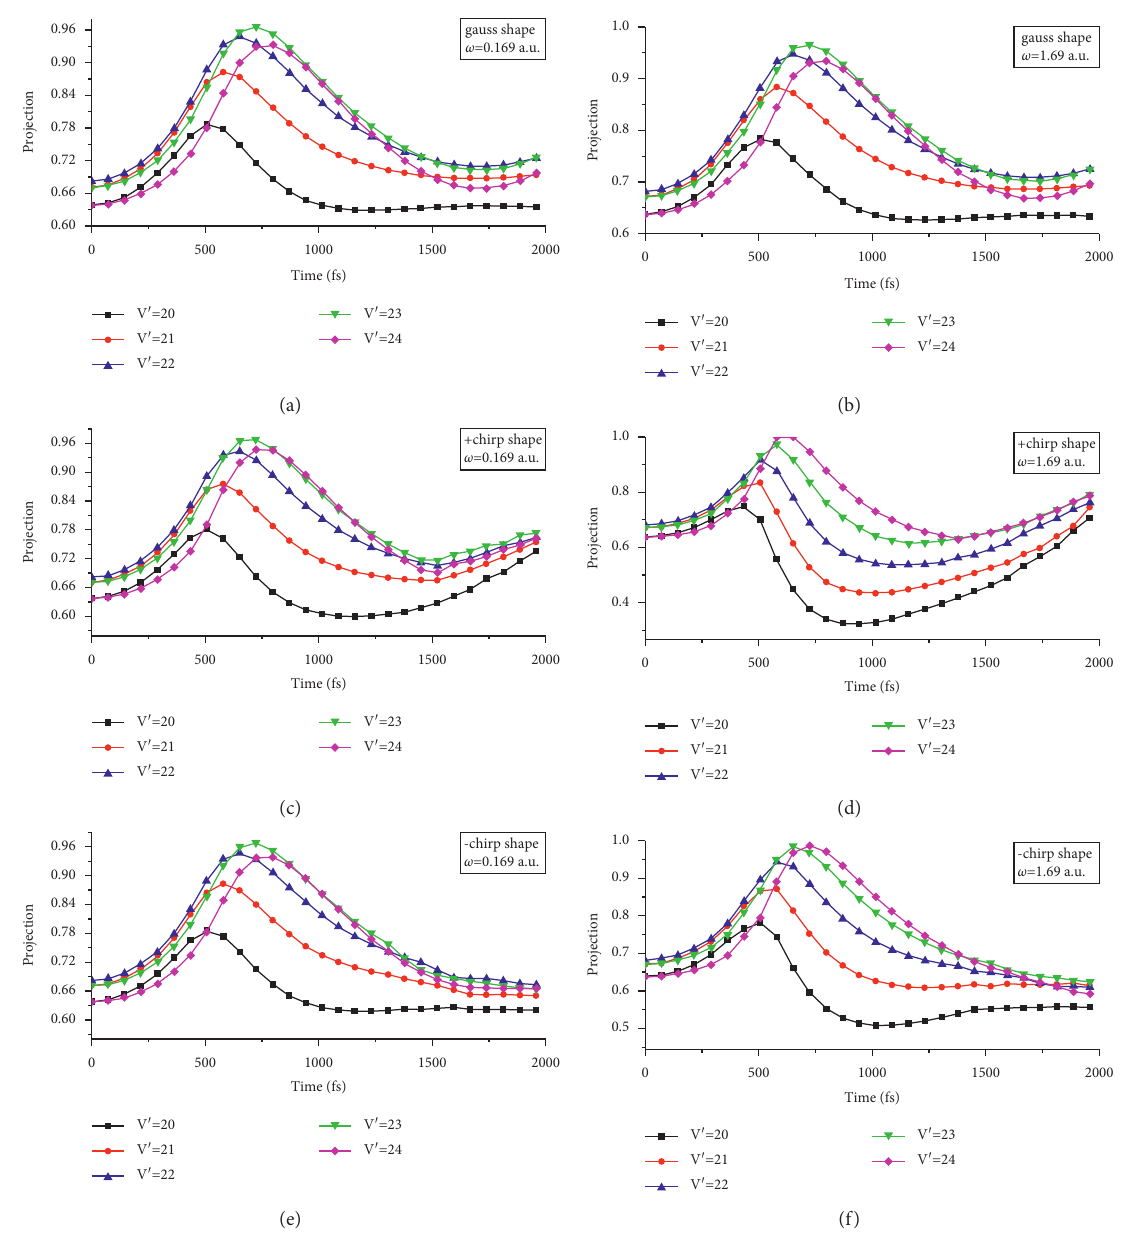
Figure 6: The effect on the projection of the A 1 Σ u+ state by changing pulse shapes and laser intensities: (a, b) Gaussian profile; (c, d) +chirp profile; (e, f) − chirp